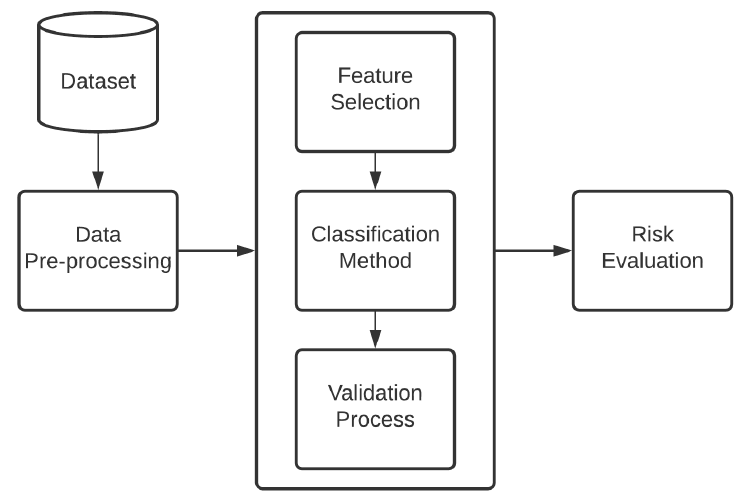
Figure 1. Flowchart representing the proposed methodology.